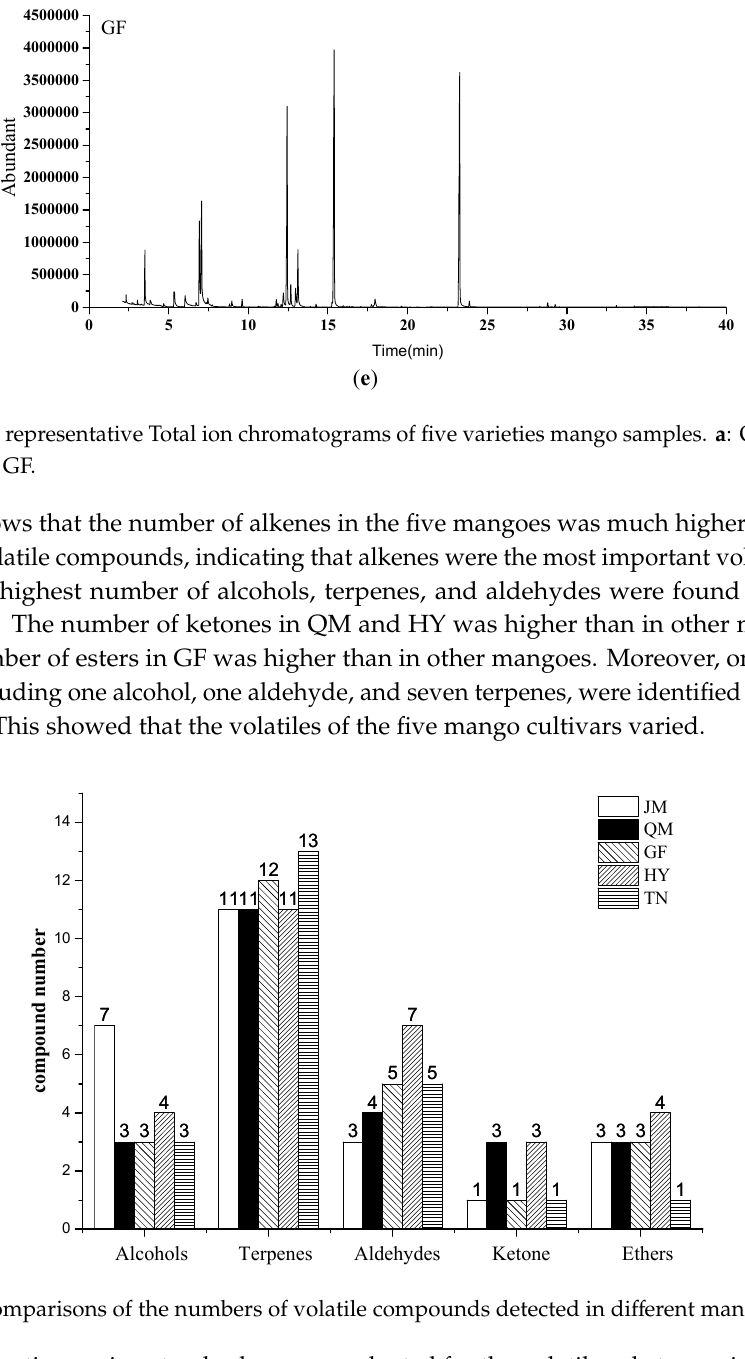
Figure 3. Comparisons of the numbers of volatile compounds detected in different mango samples